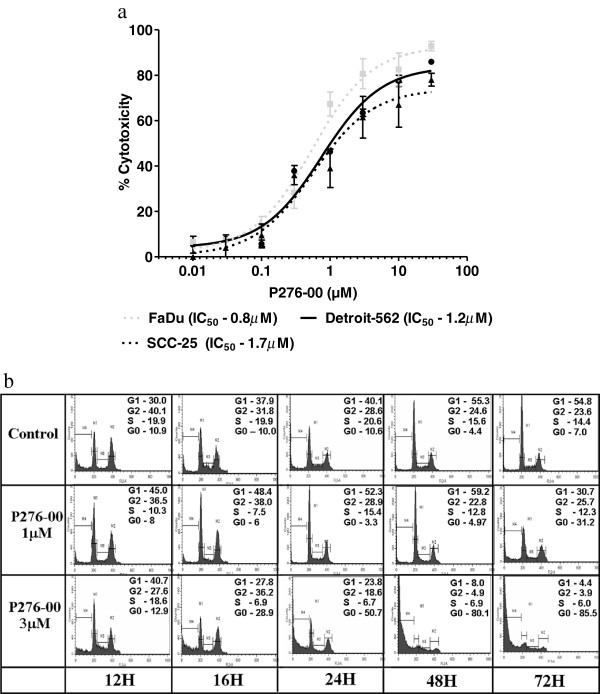
In vitro efficacy of P276-00 caused by G1 arrest in HNSCC cells (a) Anti-proliferative effect of P276-00 on HNSCC cells using CCK-8 assay. Cells (Detroite-562, filled circles; SCC25, filled triangles, and FaDu, filled boxes) were treated to 5 different concentrations of P276-00 (range: 0.1-10 μM) and measured after 48 hours. Here data is expressed in % cytotoxicity mean ± S.E.M. (n = 3). The IC50 of each cell line was calculated. (b) Flow cytometric analysis of asynchronous population of FaDu cells exposed to either P276-00 (1 and 3 μM) or DMSO for different time points (12, 16, 24, 48 and 72 hours). Histograms of cellular DNA content obtained by flow cytometry have been represented. The (%) DNA content for each phase of the cell cycle is indicated, which was determined by ModFit analysis.